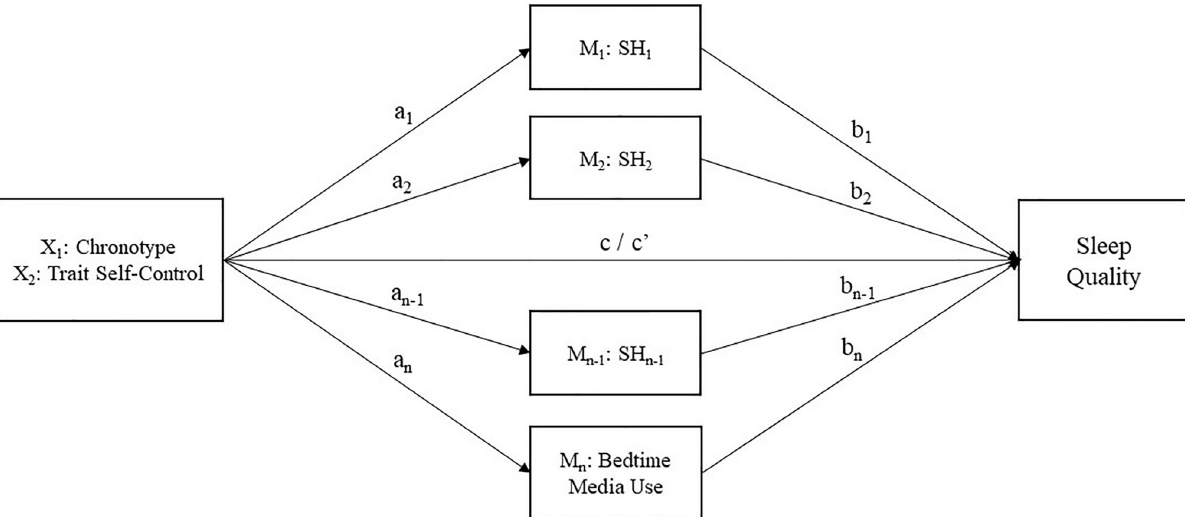
Fig 1. Proposed multiple mediation model. Chronotype and trait self-control were considered as independent variables (X 1 , X 2 ), sleep hygiene habits (M 1 –M n-1 ) and bedtime media use (M n ) as mediators and sleep quality as outcome variable (Y). X can affect Y either directly (c’) or indirectly through M 1 -M n (a 1 -a n , b 1 -b n paths). Age, gender, and marital status were included as covariates. N represents the number of mediators, and n-1 was determined by the number of sleep hygiene components derived from exploratory factor analysis of the item scores of Sleep Hygiene